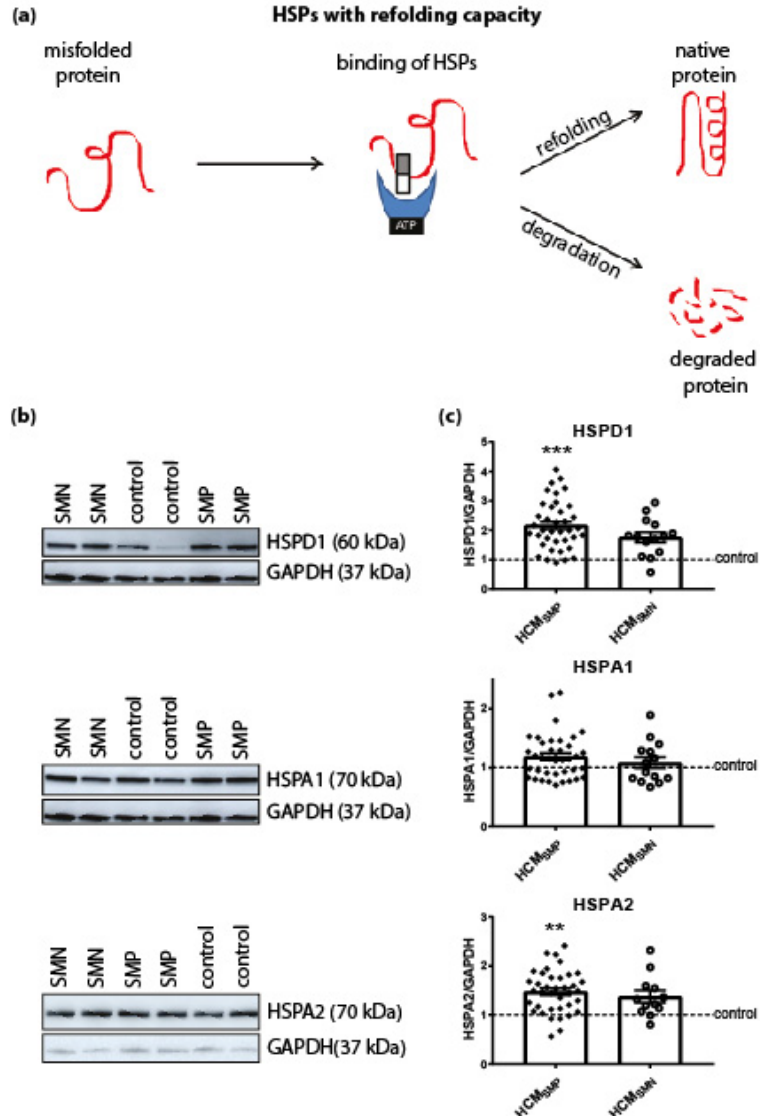
Figure 2. HSPs with a refolding capacity. ( a ) HSPs with ATPase activity and stabilizing HSPs bind to the misfolded protein to stabilize and further process it. HSPs with a refolding capacity either refold the misfolded protein to its native structure or, if refolding is impossible, the HSPs assist in the degradation